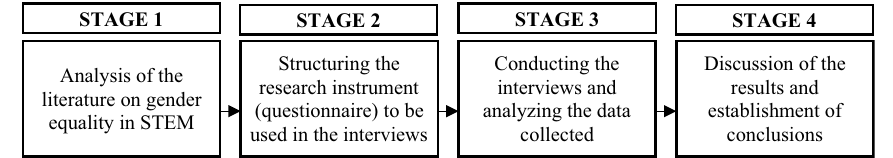
Conducting the interviews and analyzing the data collected